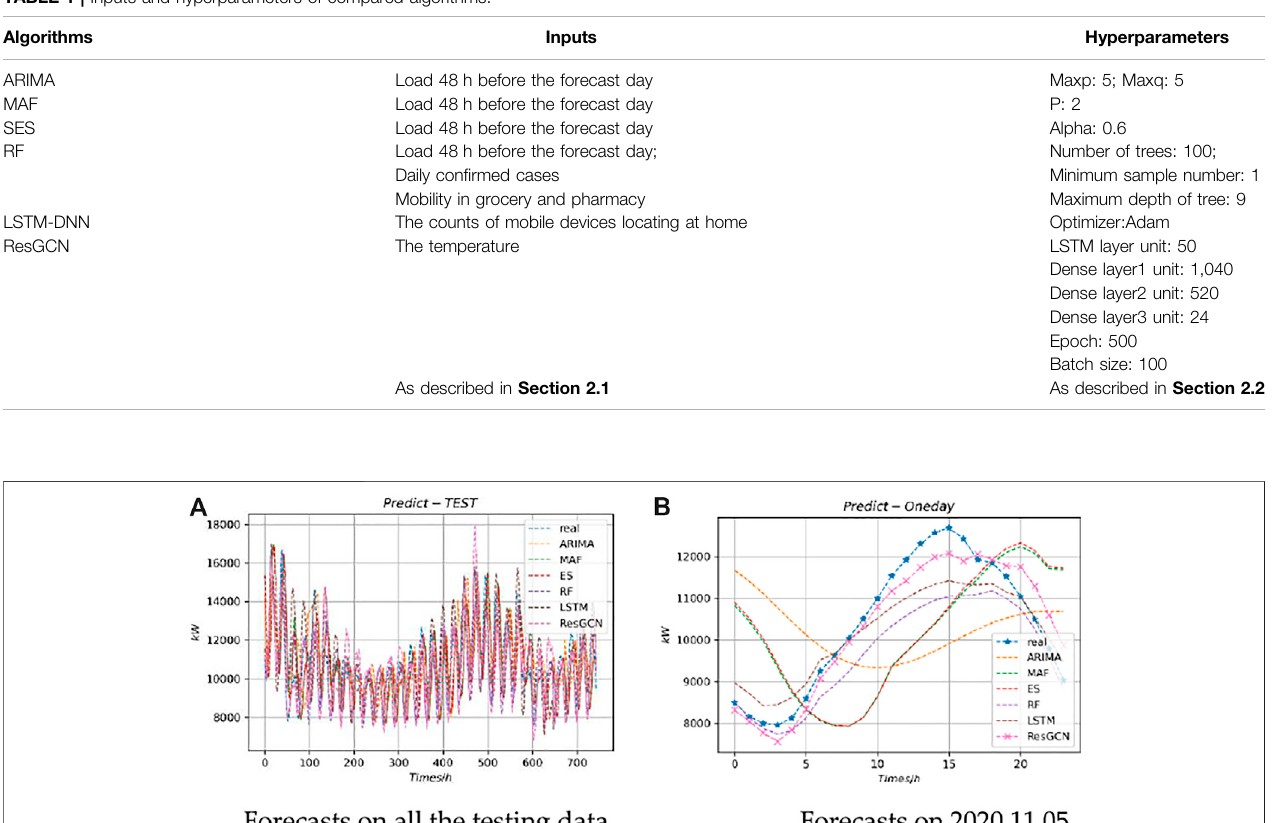
TABLE 1 | Inputs and hyperparameters of compared algorithms.